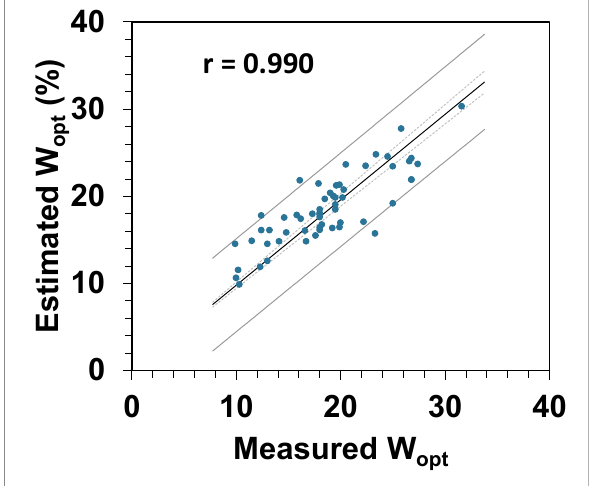
Figure 4. Correlation between measured and estimated w opt using estimated γ dmax with data from [19].